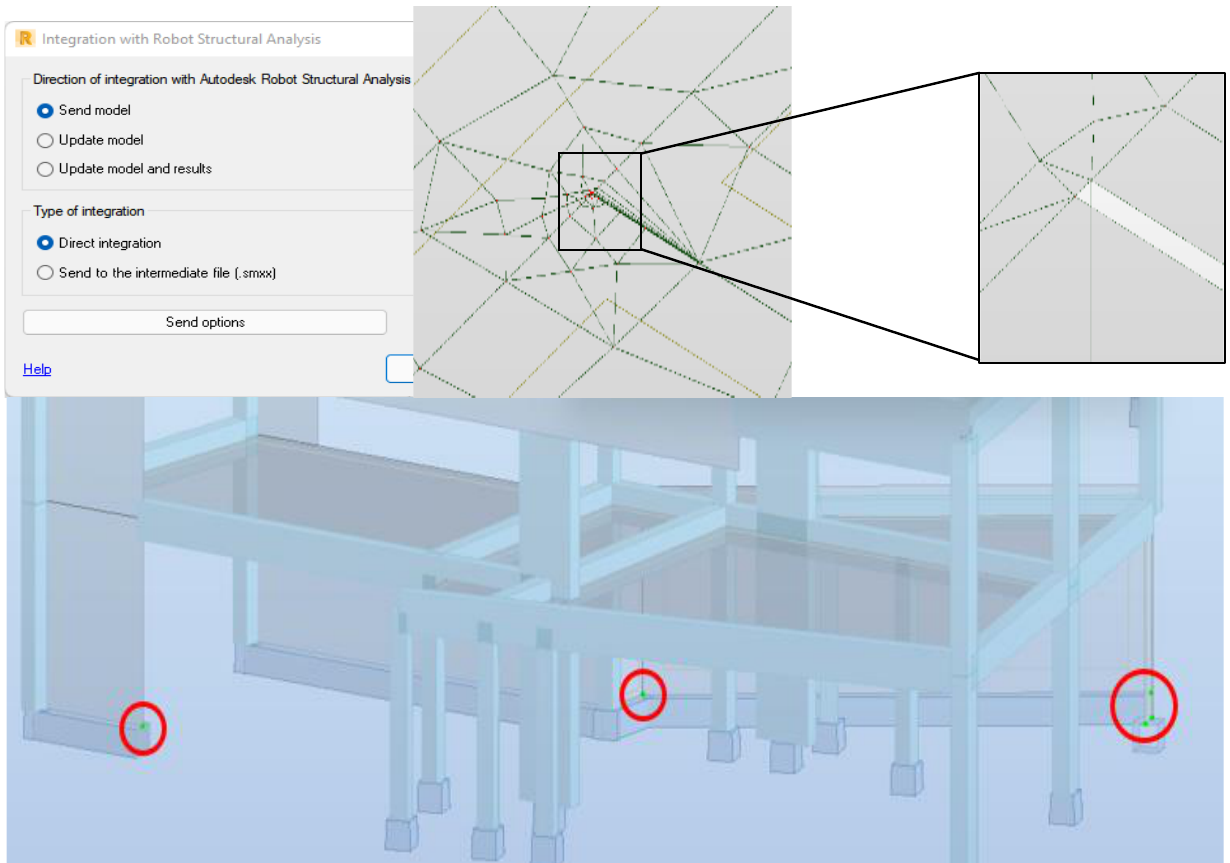
Figure 6. Direct integration option, incoherent zone in the finite element mesh, and isolated nodes detected.